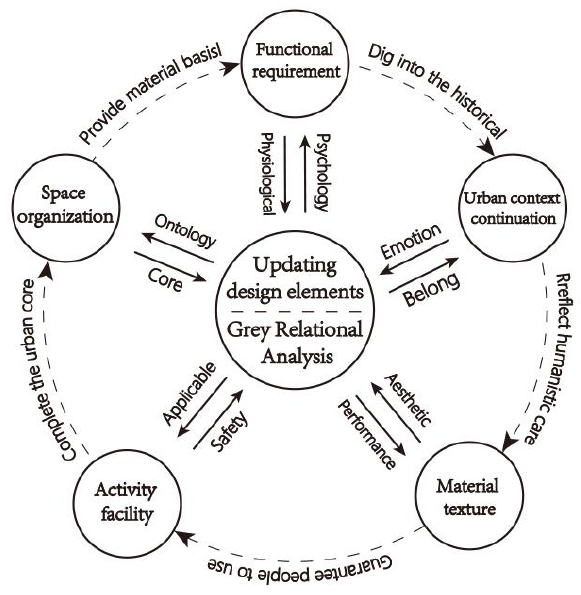
Figure 3. Design elements for sustainable renewal of urban vulnerable spaces.